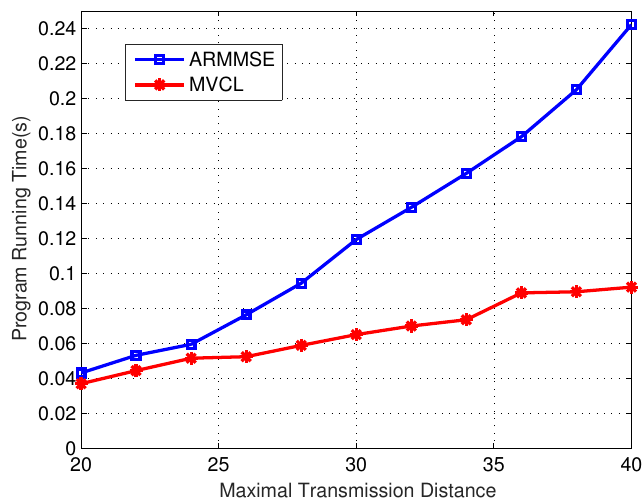
Figure 19. Operation time with maximal transmission distance ( n = 80, m = 20, k = 4, ζ = 15, η = 3).